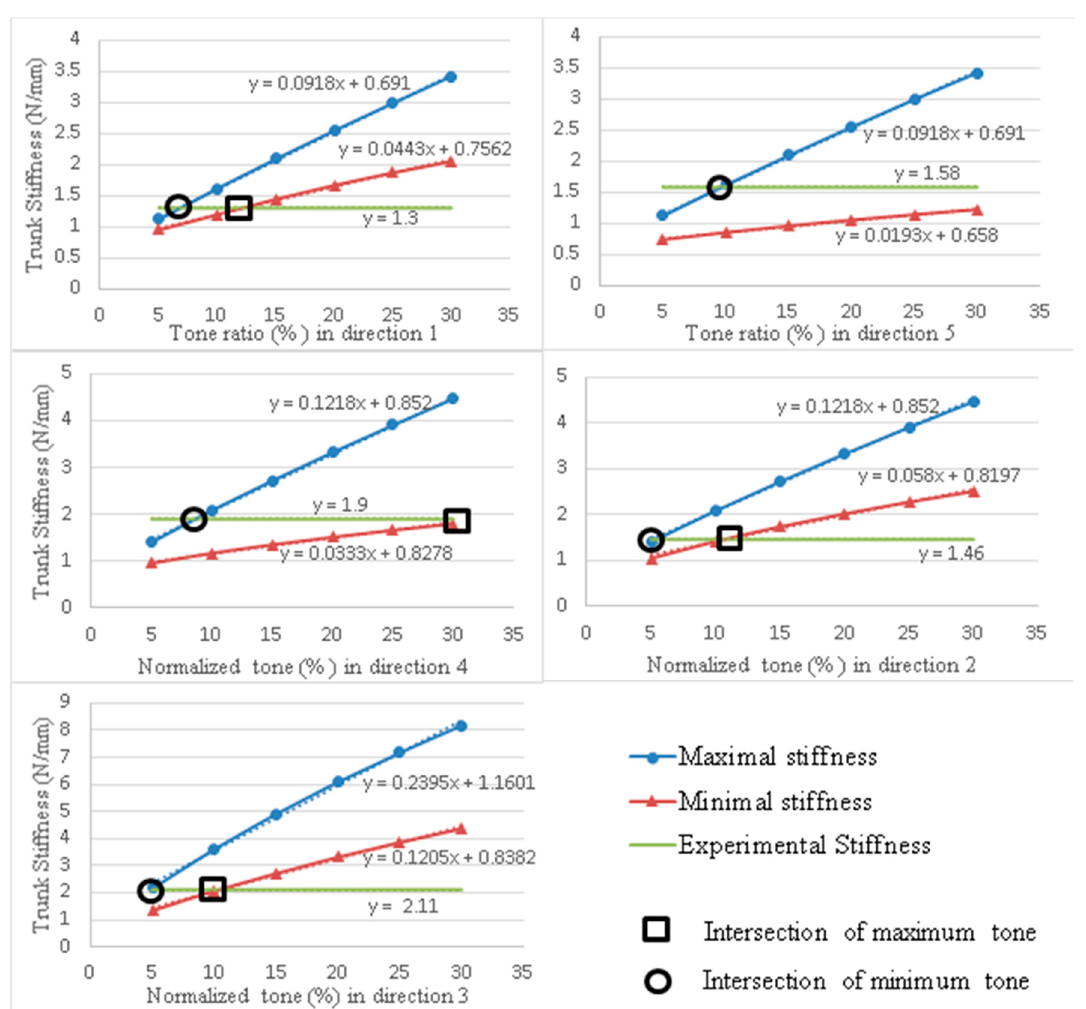
Figure 3. Maximal and minimum stiffnesses as functions of tone ratio for the five displacement directions: intersections with the experimental stiffness lines. The error between the calculated stiffness and linear regression value is everywhere less than